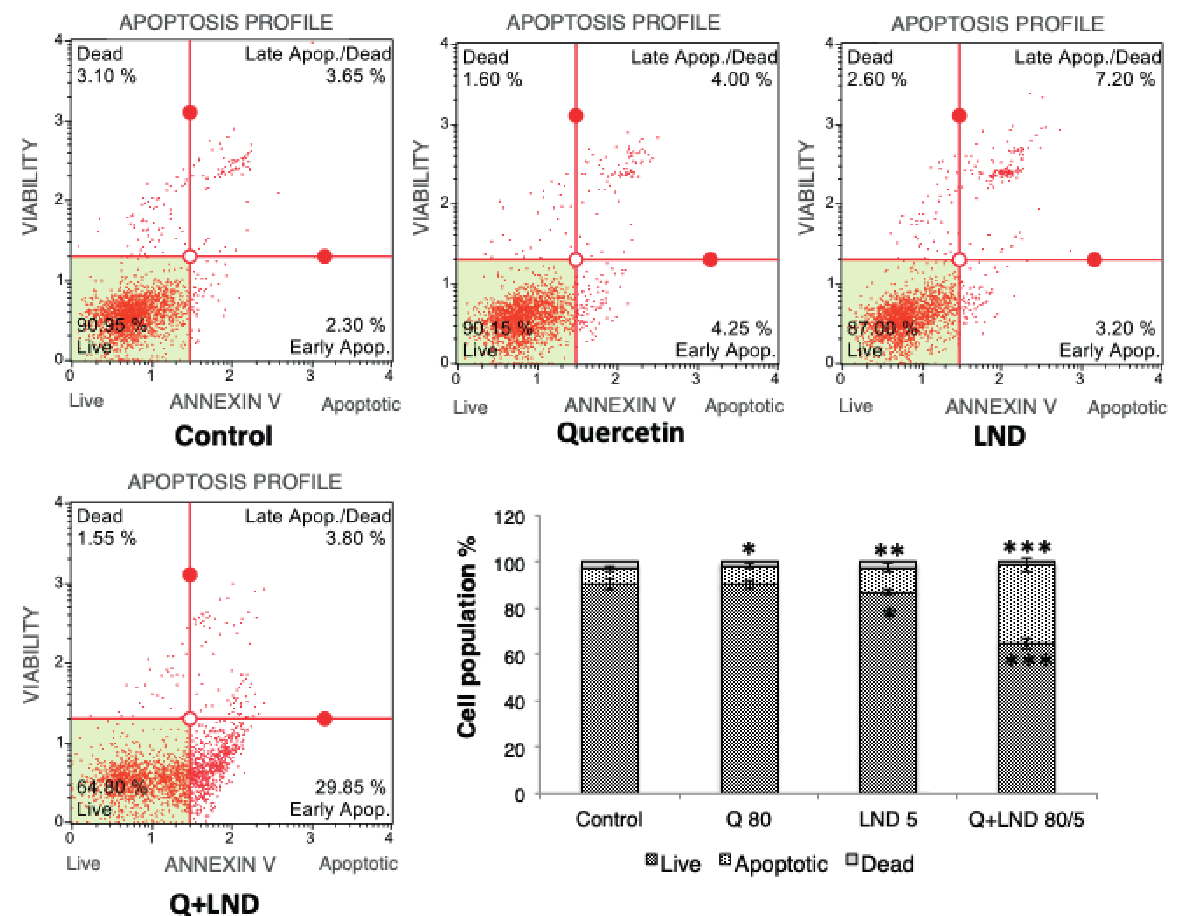
Figure 3. The results of Annexin V binding assay. The cells were treated with 80 μM of quercetin, 5 μM of LND and 80/5 μM of Q+LND combination for 24 hr, and the apoptosis was detected by Muse cell analyzer (Millipore). Nontreated cells were used as control. The apoptotic cells were determined by the Annexin V positivity based on phosphatidylserine exposure and dead cells were determined by the nuclear dye 7aminoactinomycin D (7- AAD) positivity. Four different cell population were enabled to determine by cytofl uorometric separation on a Muse cell analyzer: non-apoptotic live (lower left (LL): 7-AAD negative, apoptosis negative), non-apoptotic dead (upper left (UL): 7-AAD positive, apoptosis negative), apoptotic live (lower right (LR): 7-AAD negative, apoptosis positive), and apoptotic dead (upper right (UR):7-AAD positive, apoptosis positive) cells. The fi gure represents cytofl uorimetric dot plots of three independent experiments performed for annexin V detection and mean ± SD of late apoptotic population % (bar graph). The differences are *, ** and *** from control: p < 0.05, p<0.01 and p < 0.0001,